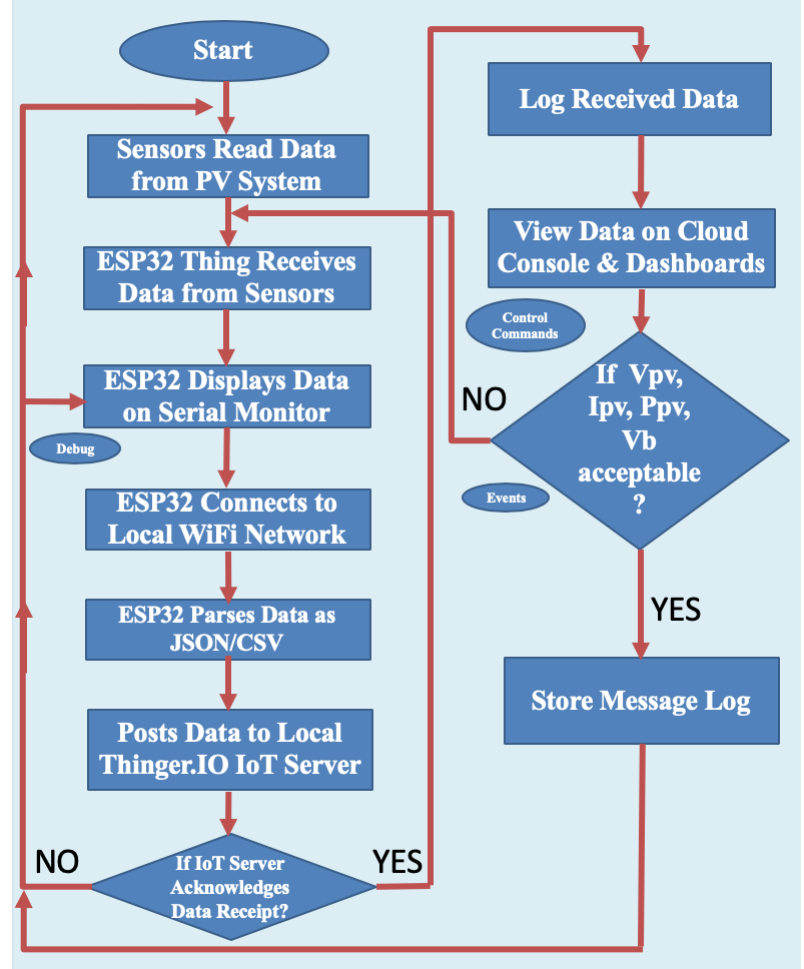
Figure 11. Flow chart of the SCADA system